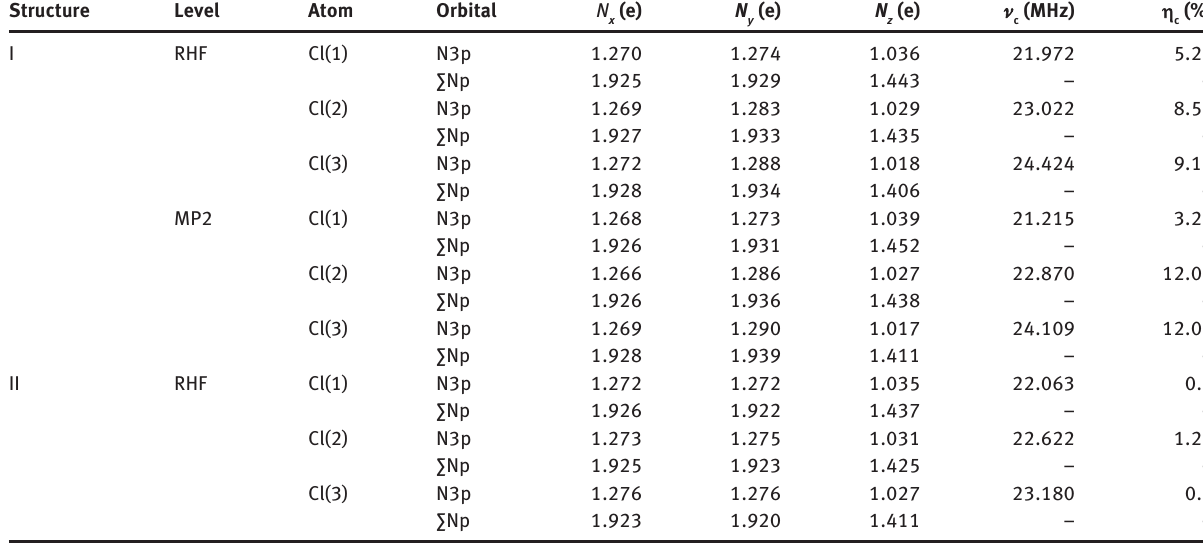
Table 2 Populations of the Cl atom valence p -orbitals ( ∑ Np) and their 3 p -components (N3p) in structures I and II obtained from the RHF/ 6-31G(d) and MP2/6-31G(d) calculations, as well as the 35 Cl NQR frequencies ( ν obtained using the populations of 3 p